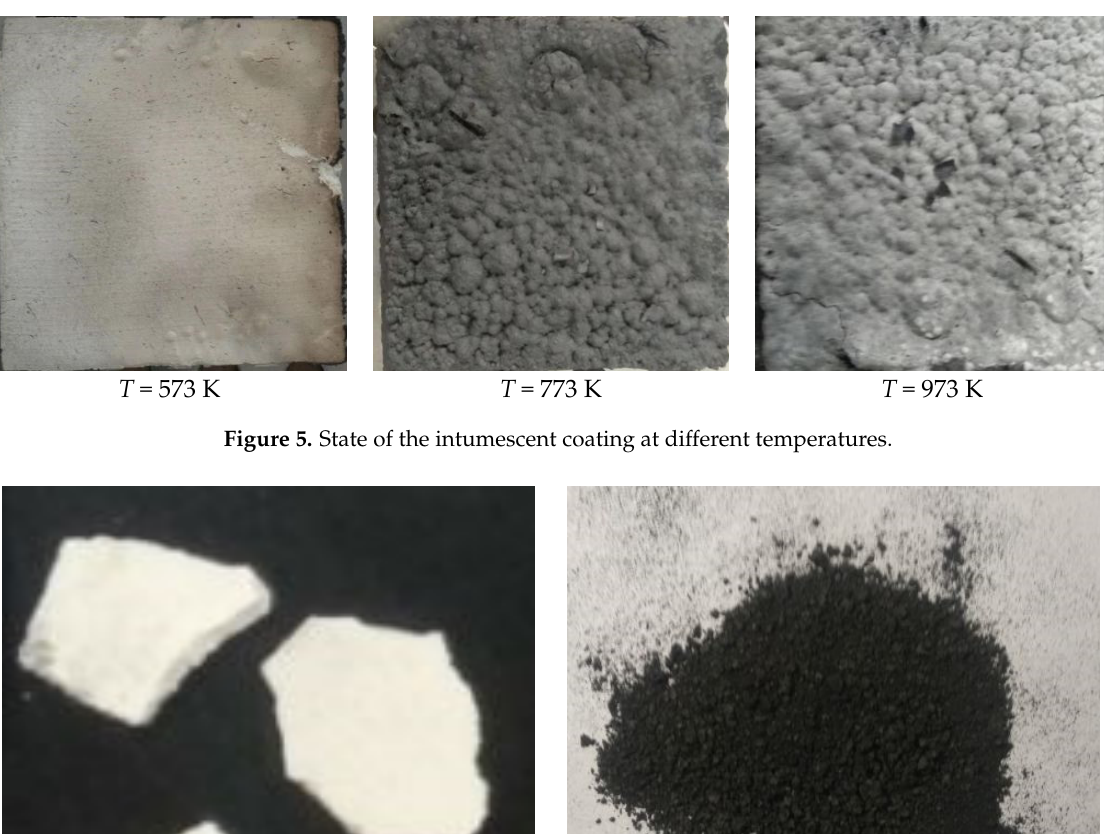
Figure 4. C-Therm conductivity meter.